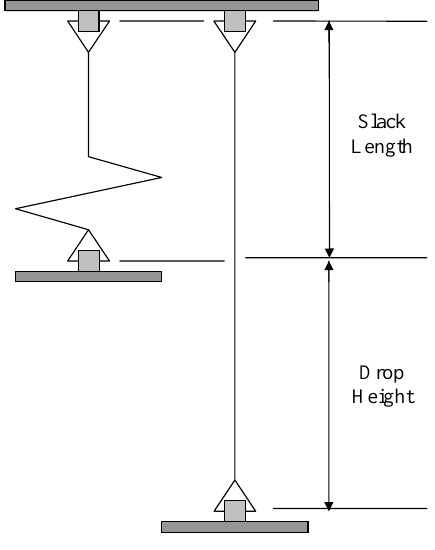
Fig. 1. Schematic of slack rope and taut